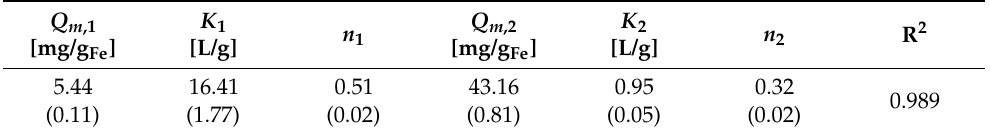
Table 4. Fitted parameters of bimodal Langmuir–Freundlich equation (SD values are shown in parentheses) obtained for ALB adsorption on the